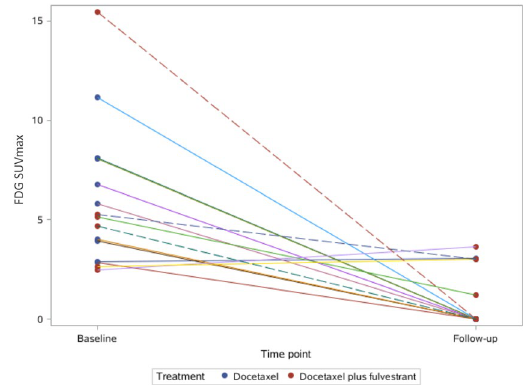
Figure 6. The spaghetti plot of 18 F-FDG changes.